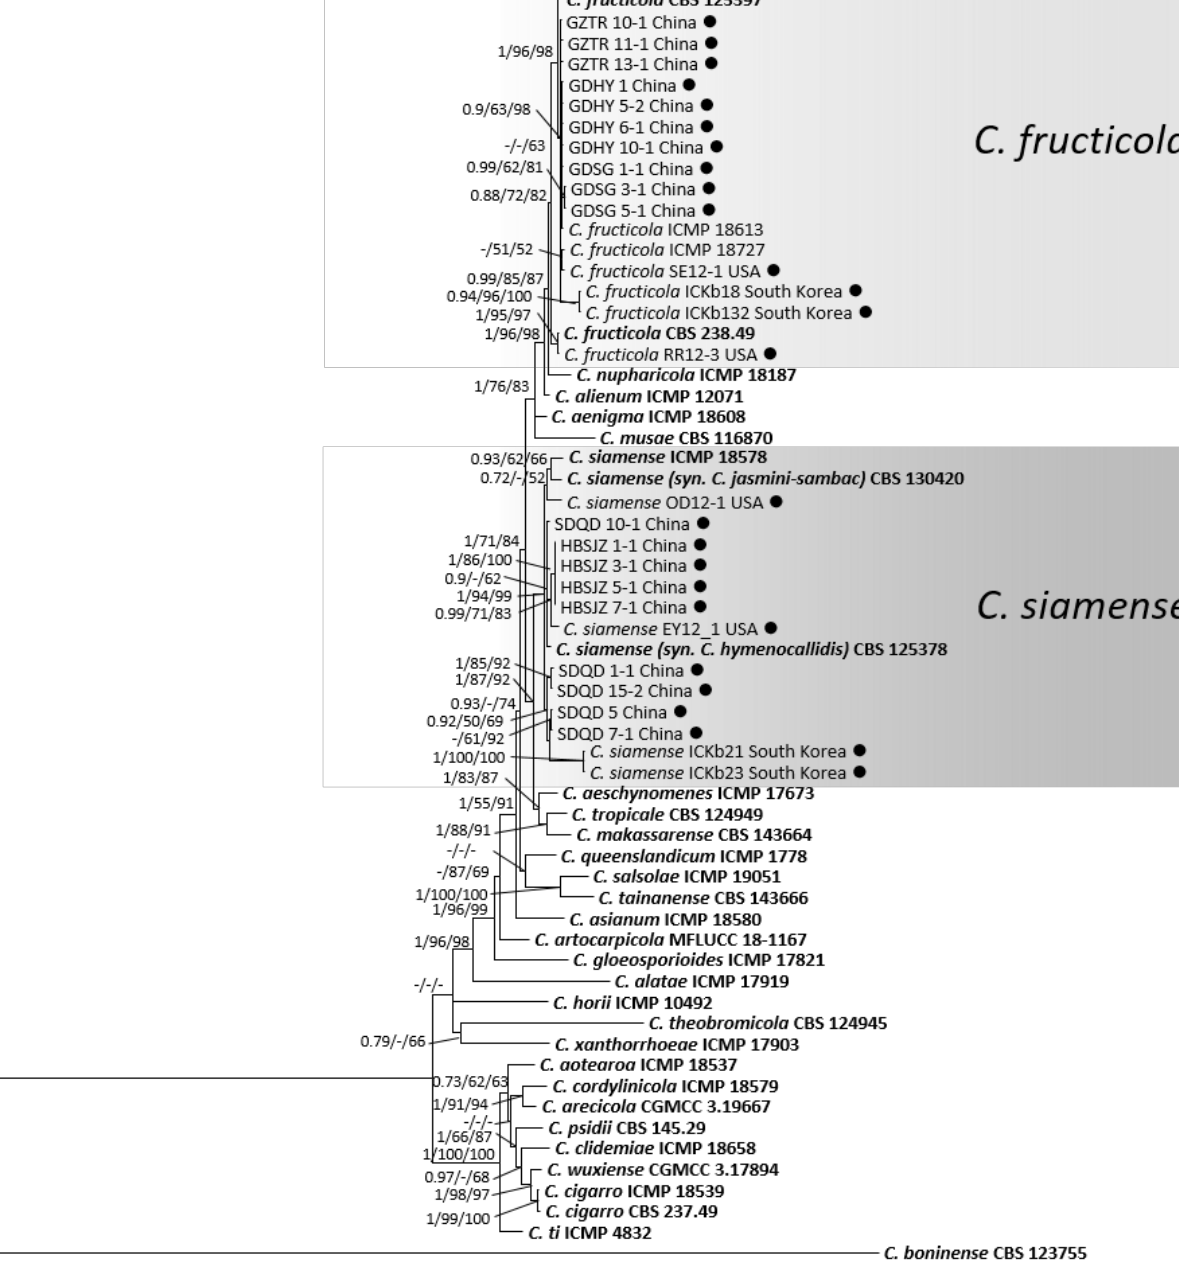
Figure 4. A Bayesian inference phylogenetic tree of 61 isolates in the C. gloeosporioides species complex. C. boninense (CBS 123755) was used as the outgroup. The tree was built using combined sequences of the ACT , CAL , CHS-1 , GAPDH , ITS, and TUB2 . BI posterior probability values (BI ≥ 0.70), MP bootstrap support values (MP ≥ 50%), and RAxML bootstrap support values (ML ≥ 50%) were shown at the nodes (BI/MP/ML). Tree length = 1303, CI = 0.76, RI = 0.84, RC = 0.63, HI = 0.24. Ex-type strains are in bold. Circles indicate isolates from fruits, and triangles indicate isolates from